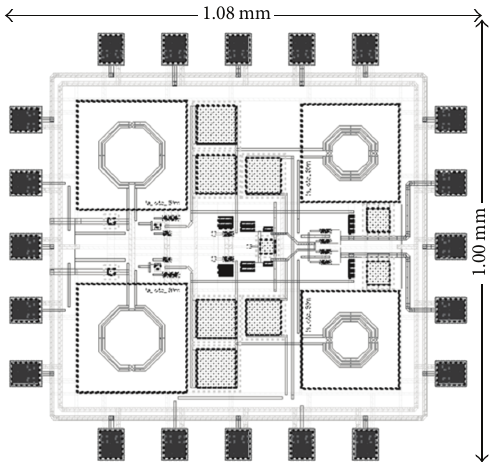
Figure 4: Physical layout of wideband mixer including RF ESD